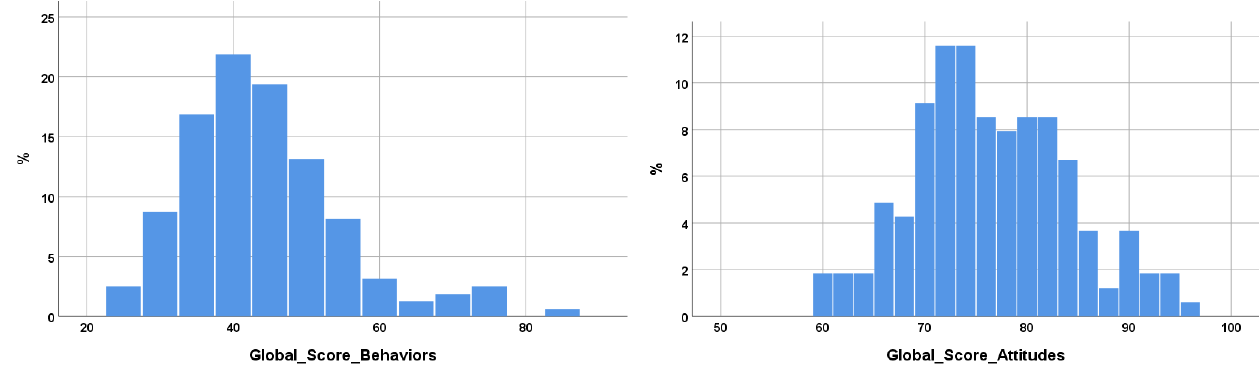
Figure 8. Distribution of global behaviors and